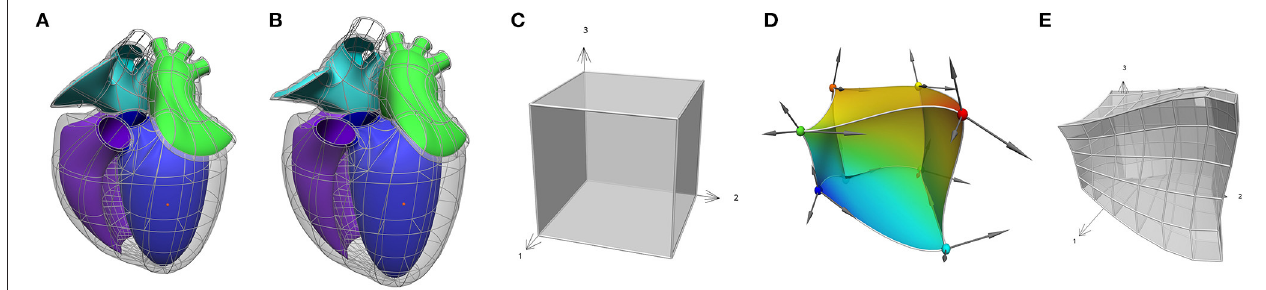
FIGURE 5 | An Example of mapping from material space to physical space. (A,B) The heart scaffold defined with 282 tri-cubic Hermite elements. (C) A single element defined with ( ξ 1 , ξ 2 , ξ 3 ) coordinates. (D) The element in (C) mapped into 3D physical space where the colors illustrate a continuous scalar field defined over that space. In addition, (E) an example of a domain refinement of the deformed cube into subdomains or “elements” is